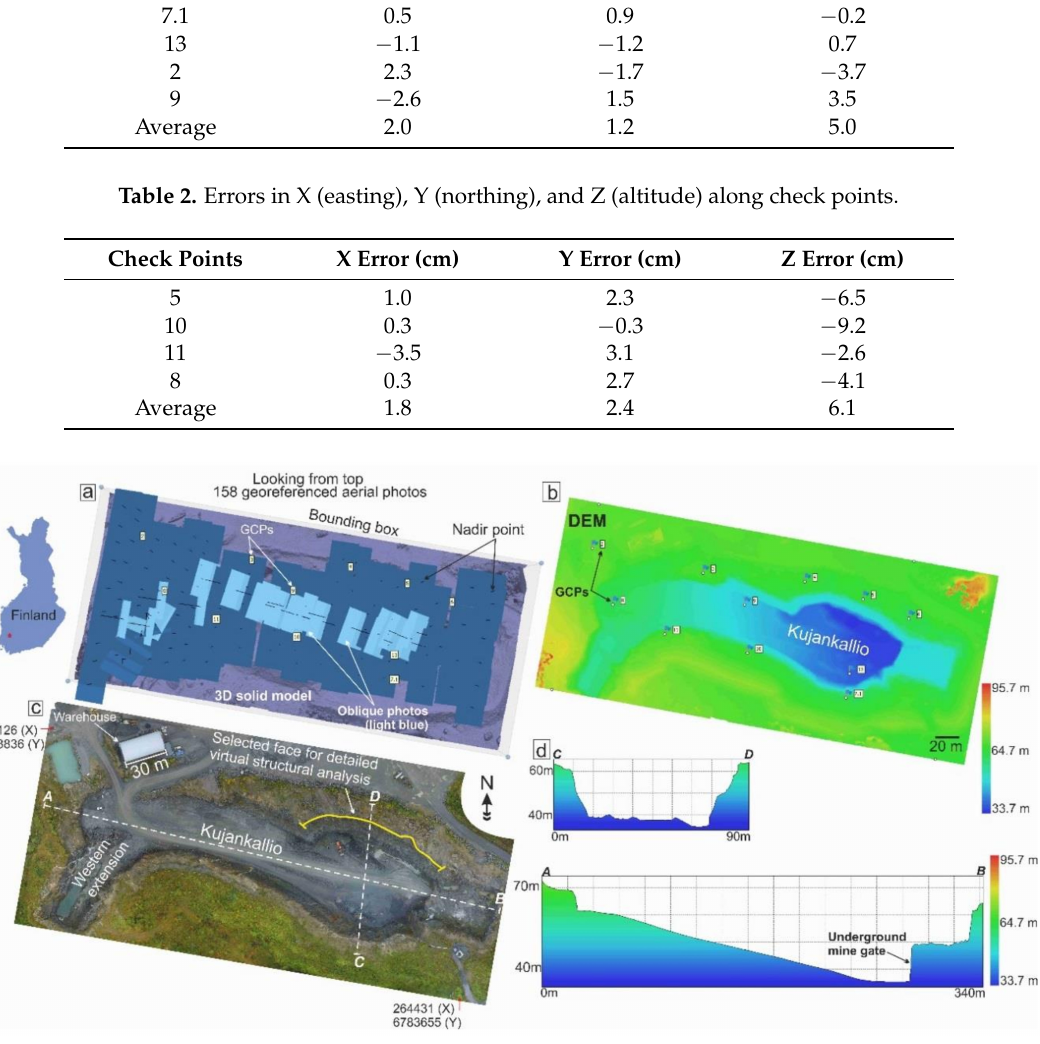
Figure 3. Steps involved for three-dimensional (3-D) model generation of the Kujankallio open pit and the western extension using SfM. ( a ) Photo alignment in a reference mode. The blue squares with nadir (center) lines represent camera positions and orientations automatically detected by the PhotoScan from the SfM process. Light blue squares show oblique images. 158 georeferenced images were taken at an altitude of ~79 m. 11 ground control points (GCPs) were deployed and incorporated their locations during the Photoscan workflow. ( b ) Digital elevation model (DEM) of the open pit showing elevation gradient from blue to red. Blue flags indicate location of GCPs. ( c ) Orthorectified image showing location of the surface profile sections and length of the warehouse. Thick yellow line showing the location of the northern face used for virtual quantitative structural analysis. Coordinates are in ETRS89/TM35FIN (3067). ( d ) Two profile sections ( AB and CD ) highlighting the surface geometry of the open